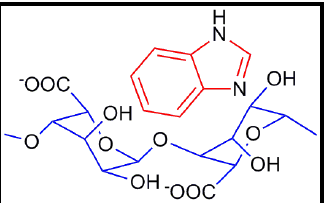
Figure 32. Chemical structure of the alginic acid-benzimidazole